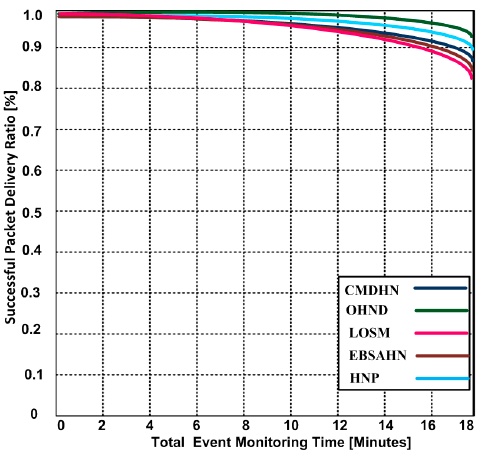
Figure 6. Successful packet delivery VS number of monitoring events.